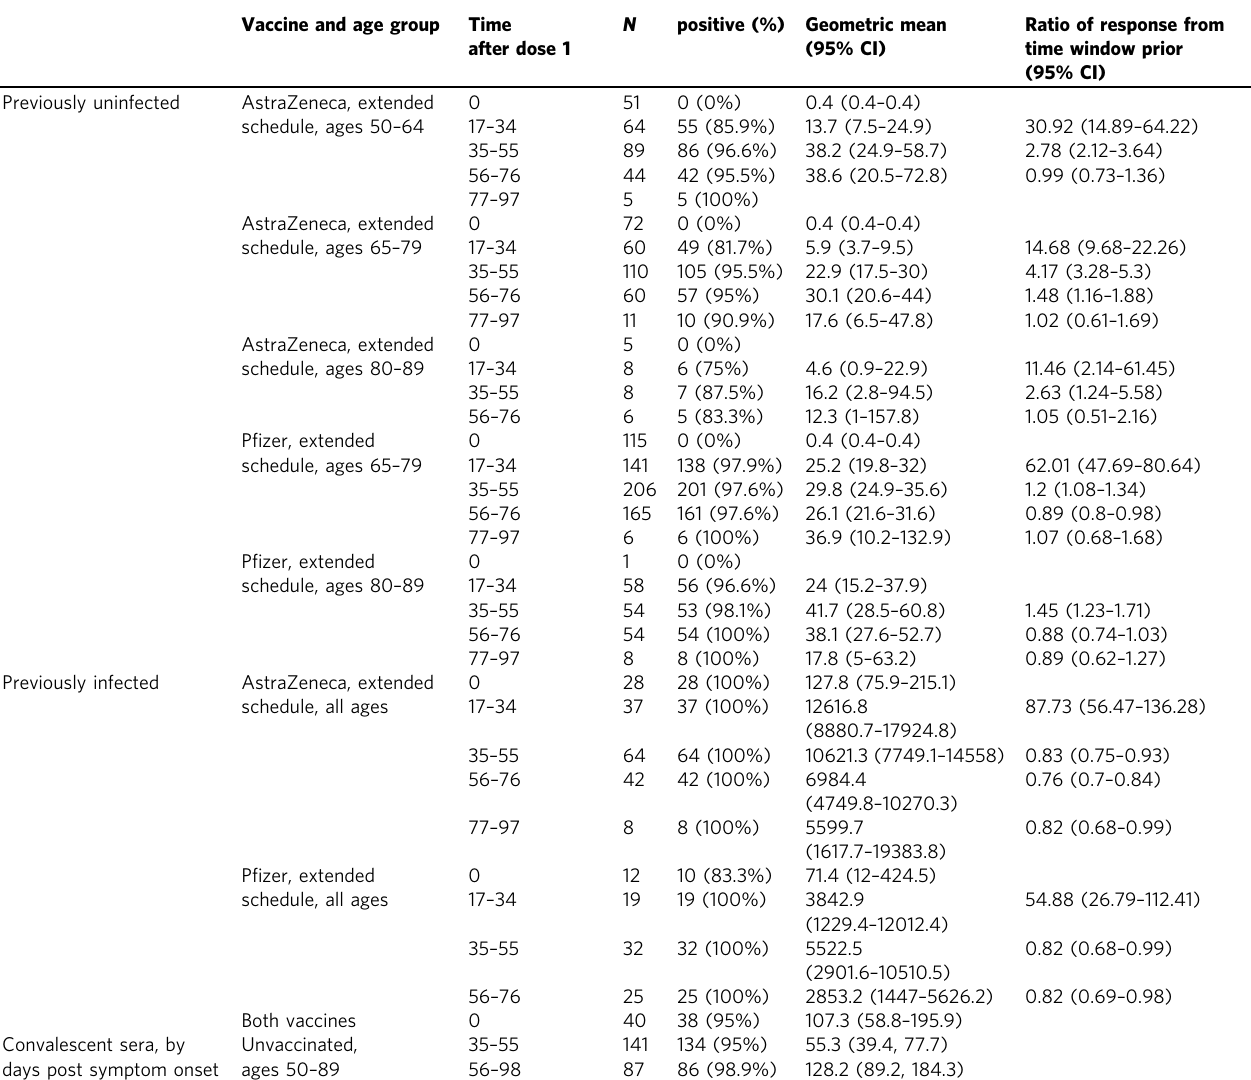
Table 1 Proportion RocheS seropositive, Geometric Mean Concentrations (if >5 samples) by vaccine type and age group and the ratio of responses by time, following dose